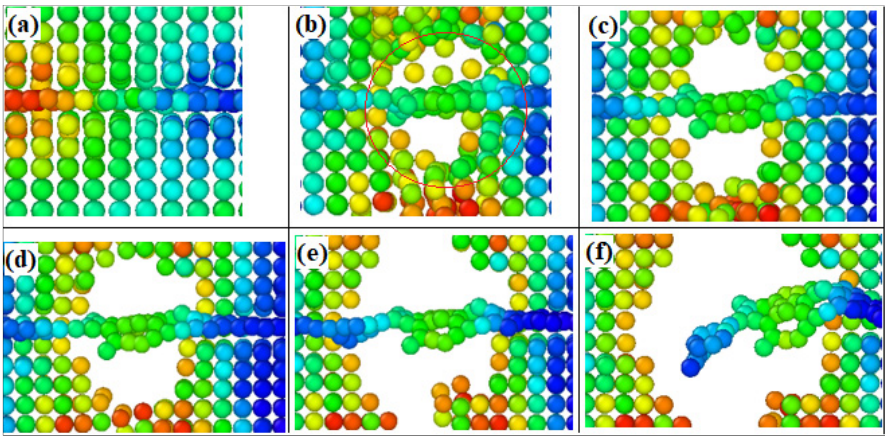
Figure 7. Stress distribution of single-layer graphene/aluminum composites during tensile failure, ( a – f ) represent the process of matrix cracking until material failure during stretching.